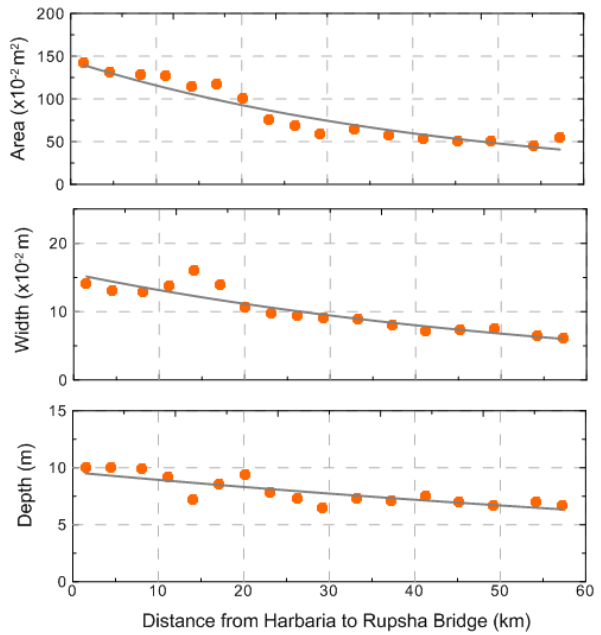
Figure 2. Cross-sectional area, width, and depth of all conductivity– temperature–depth stations in the Pasur River